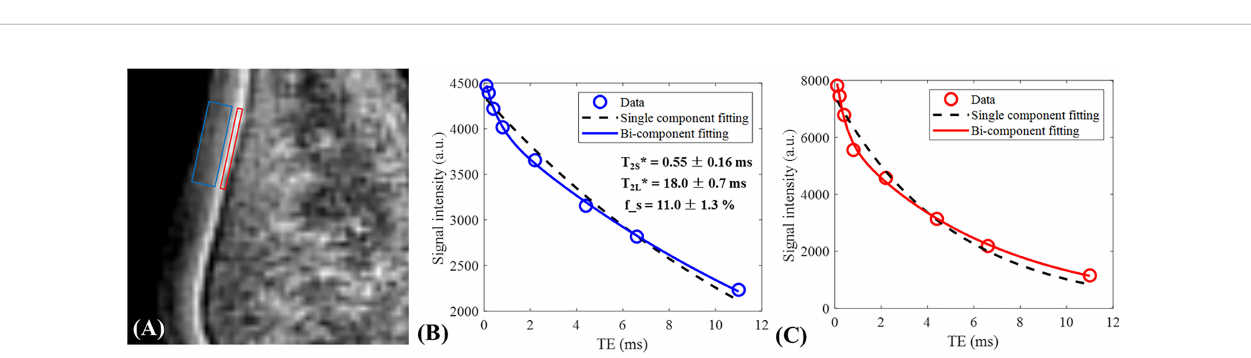
FIGURE 10 | Single- and bi-component analysis of IR-FS-UTE imaging of more super fi cial cartilage (blue region) and OCJ (red region in A ) regions. The bi- component model performs much better than the single-component model in data fi tting (B, C) . For the more super fi cial cartilage region, the T ∗ 2 values of short and long T 2 components as well as the short T 2 fraction were 0.55 ms, 18.0 ms, and 11.0%, respectively (B) . For the deeper cartilage region, the T ∗ 2 values of the short and long T 2 components as well as the short T 2 fraction were 0.38 ms, 6.5 ms, and 27.0%, respectively (C)